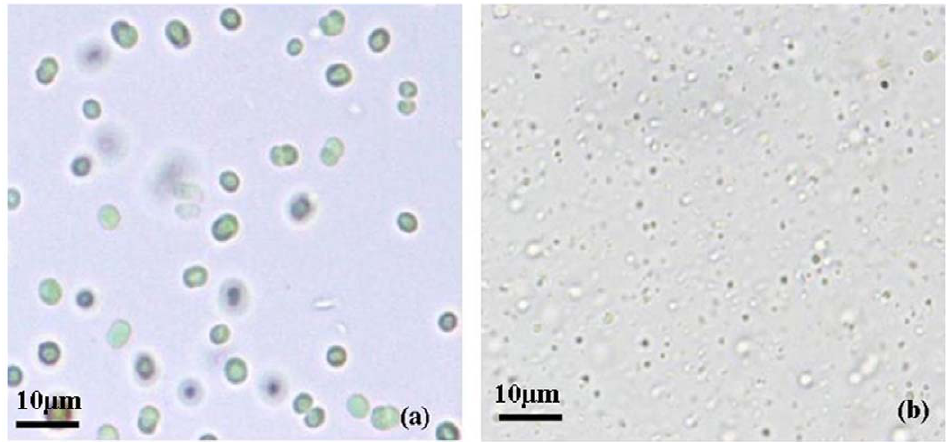
Figure 2. Photomicrograph of Synechocystis sp. strain PUPCCC 64 culture on day 4. (a): control; (b): anilofos (30 mg L 2 1 ).